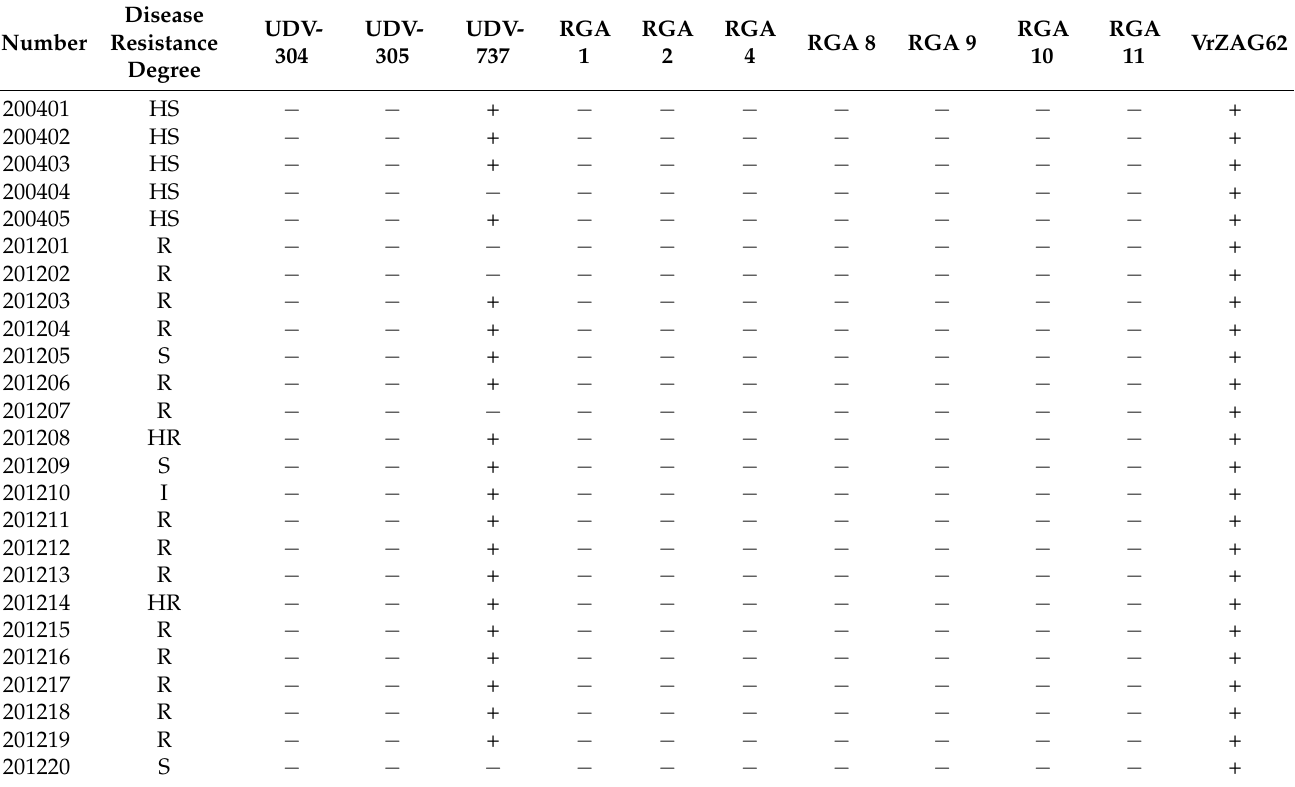
Table 5. Amplification results of nine markers in hybrid F 1 population of combination